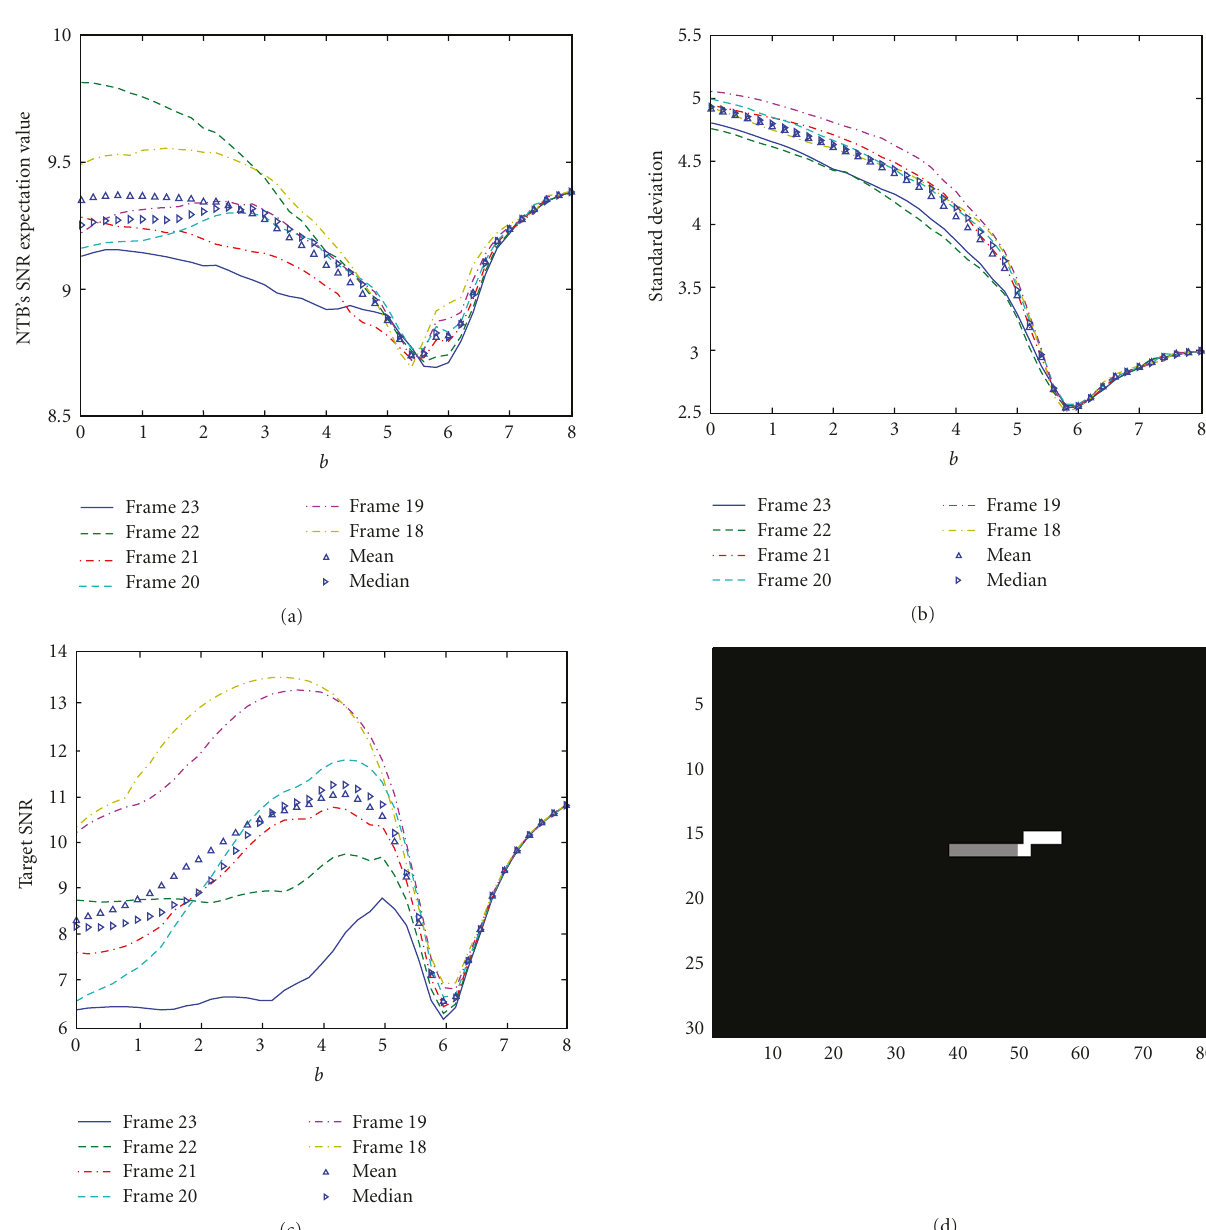
Figure 14: NA23A sequence, s n = 4. (a) Standard deviation of NTB’s SNR, (b) expectation value of NTB’s SNR, (c) TB’s SNR, and (d) the target’s track (the pink track is the target track for s n =